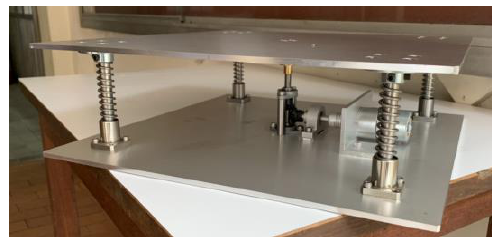
Figure 13. Photograph of Rack and Pinion Prototype.